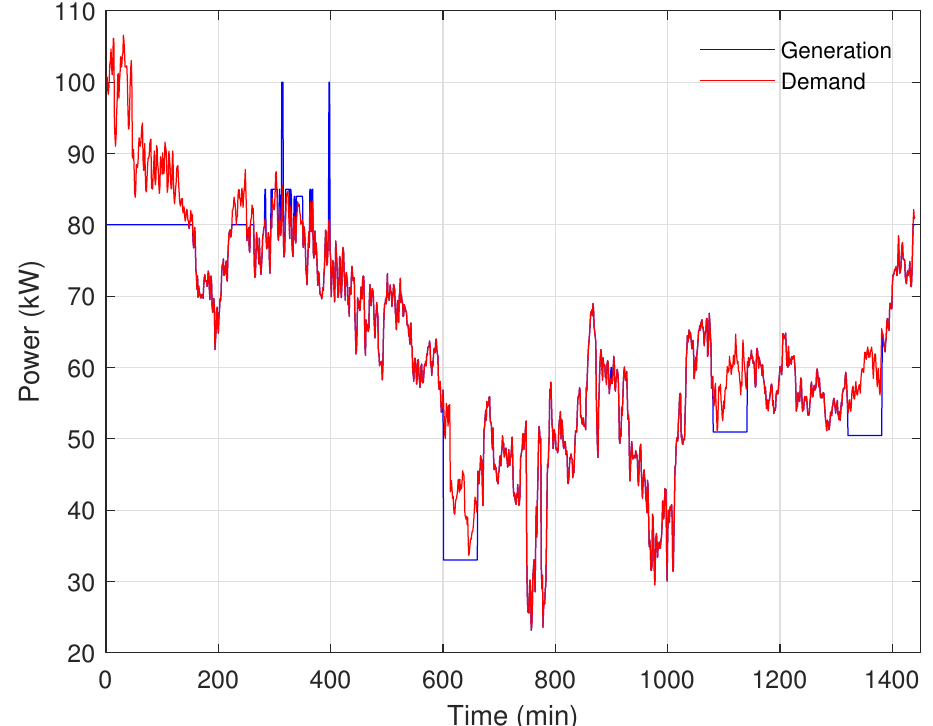
Figure 4. Demand and supply profile on a feeder for a single day.